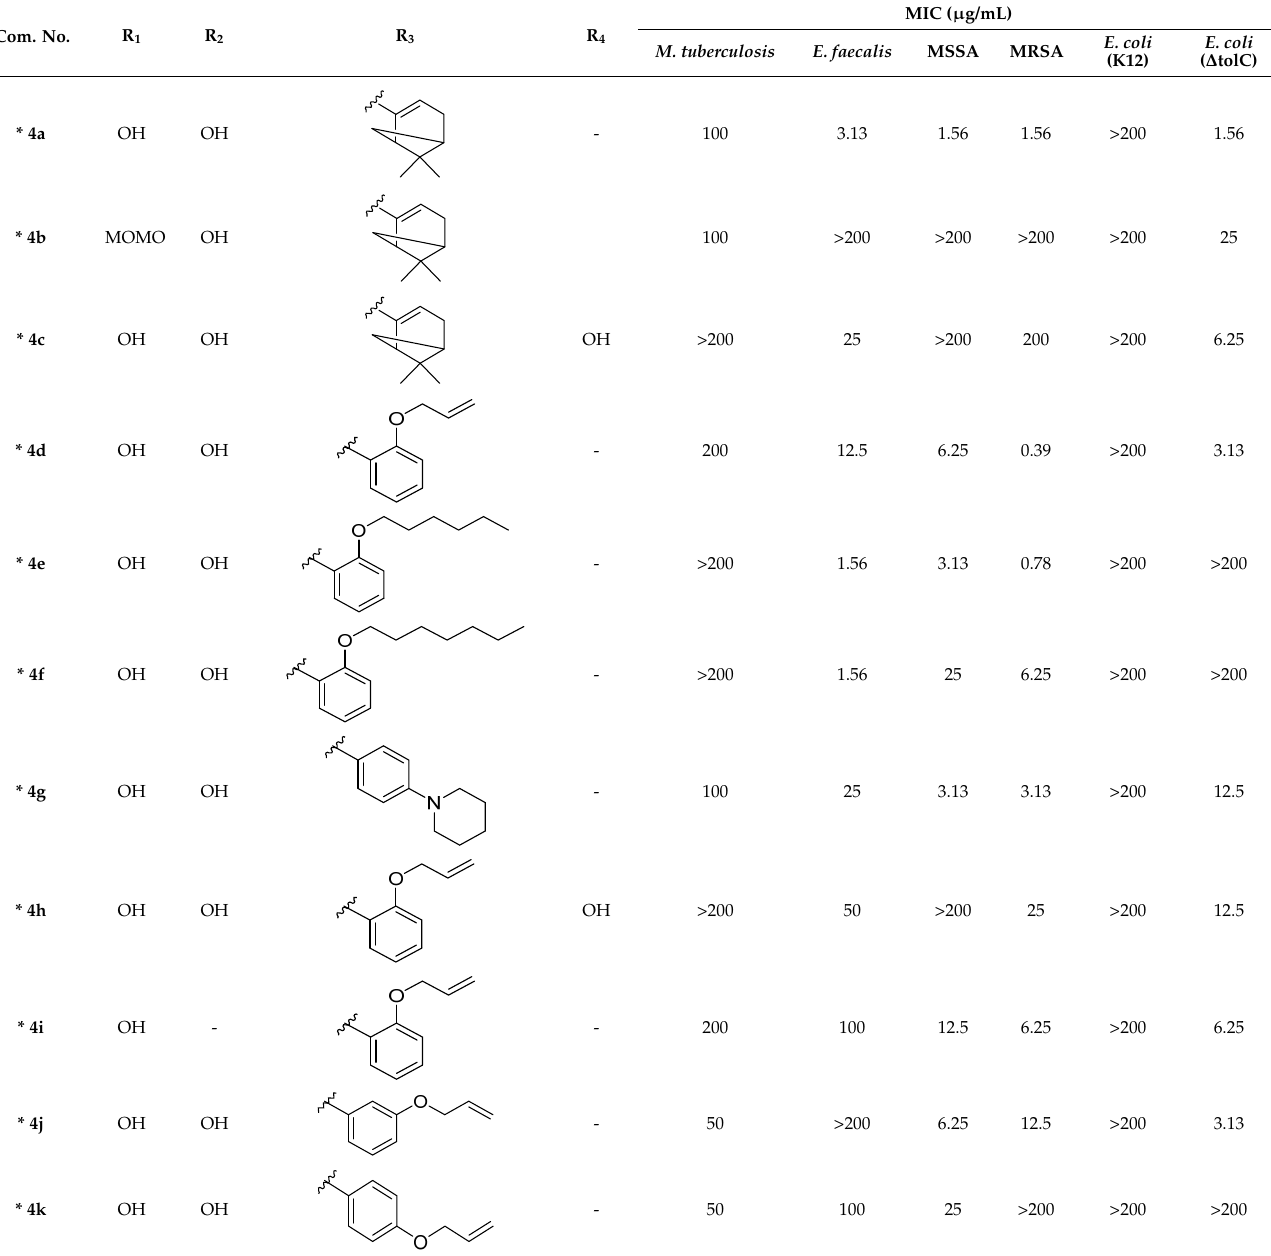
Table 9. Chalcones ( 4a – k ) showed good antibacterial activity against Gram-positive bacteria. Com. No.